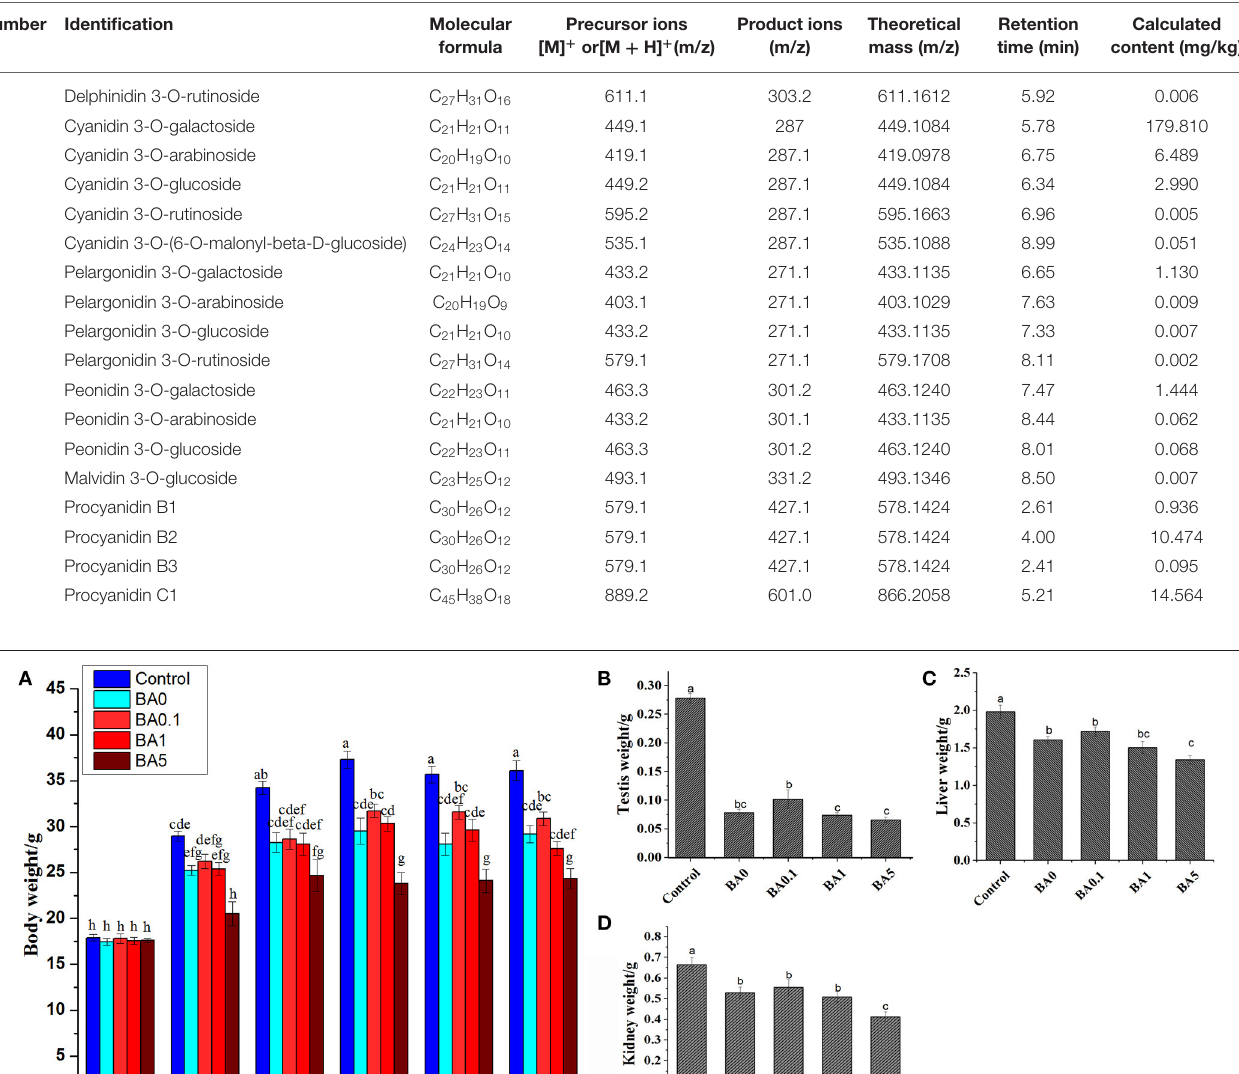
TABLE 1 | Analysis of anthocyanin and proanthocyanidin compounds in RAAE. Number Identification